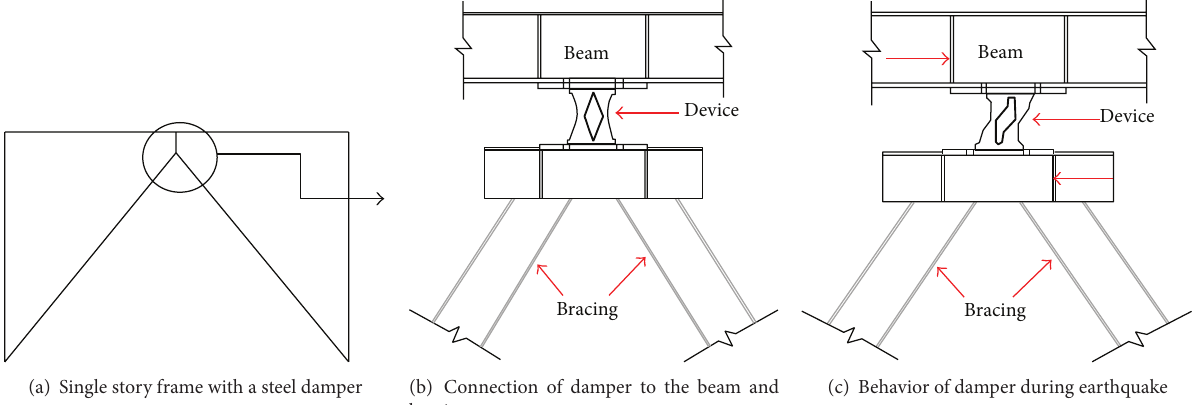
Figure 2: Typical installation of steel damper in chevron